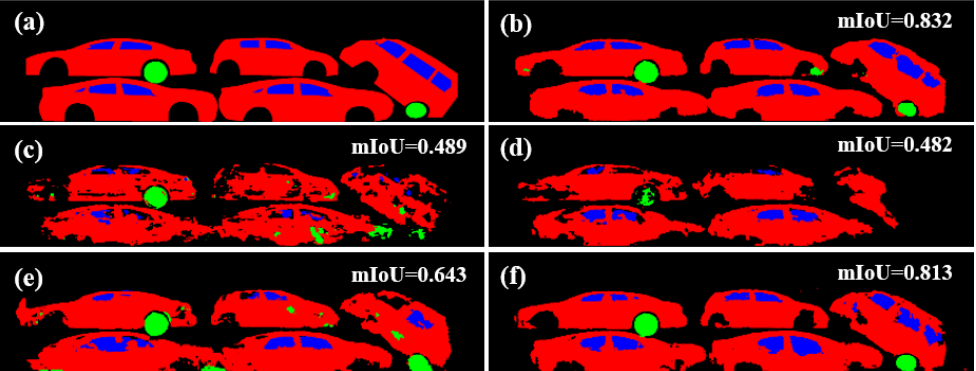
Figure 10. Segmentation results when different fake images are used as the training set: ( a ) Ground- truth semantic label. ( b ) Result obtained by using real BSX training data. ( c – f ) Results obtained by using only fake images from pix2pix, SEF, LBP, and LTH,